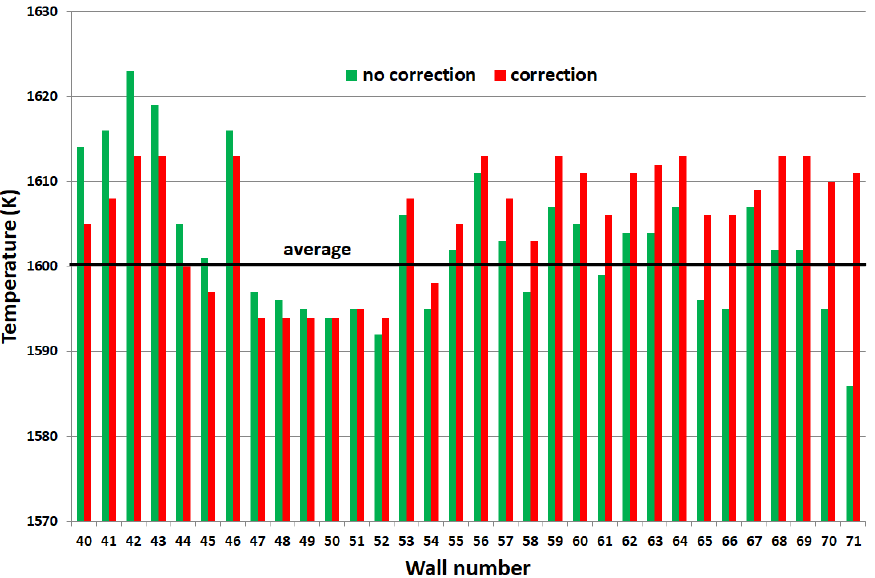
Figure 8. The results of temperature measurements in selected heating flues at one of the Polish coke oven batteries (PWR-63), without and with the use of correction coefficient.